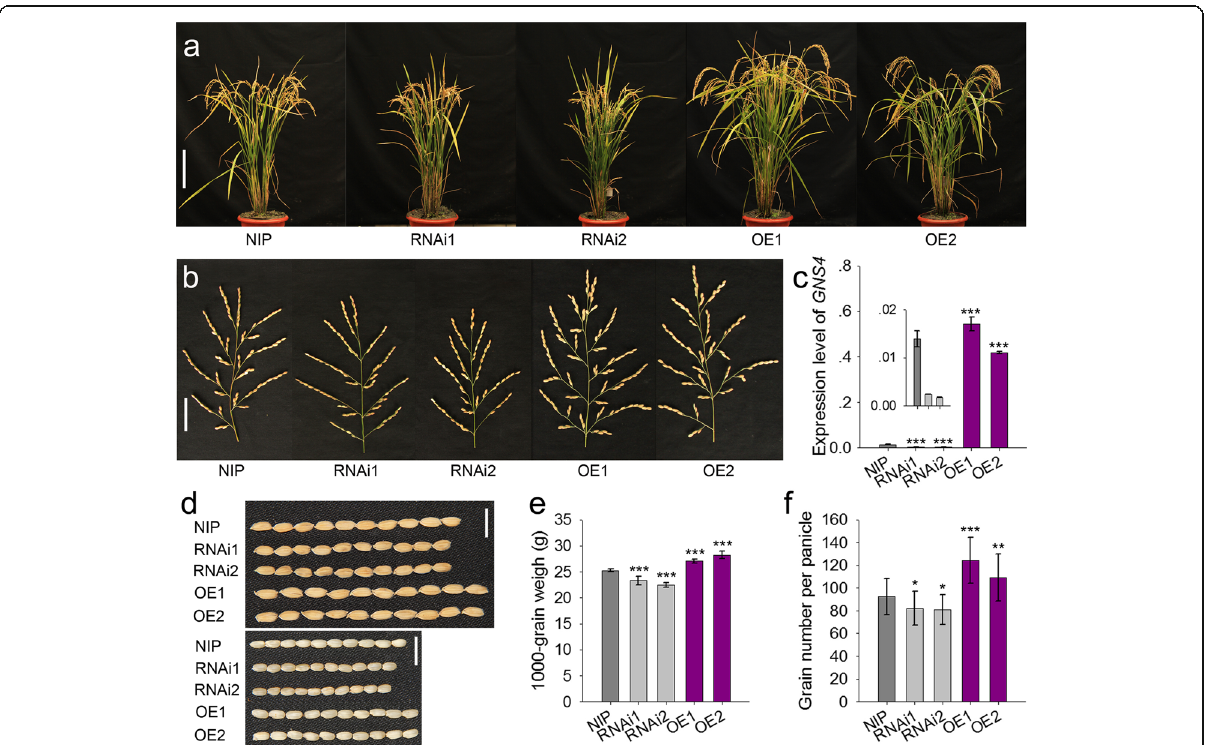
Fig. 3 RNAi and overexpression analysis of GNS4 gene in Nipponbare background. a Phenotypic features of GNS4 RNAi and overexpression transgenic plants. Bar, 20 cm. b Panicle architecture of GNS4 RNAi and overexpression transgenic plants. Bar, 5 cm. c GNS4 mRNA expression level of the RNAi and overexpression transgenic plants. The expression level of the rice Actin gene was amplified as a control. Values are means ± s.e. of four independent experiments. d Grains of the transgenic plants. Bar, 1 cm. e-f Comparison of 1000-grain weight and grain number per plant between Nipponbare and transgenic lines. Data are given as means ± s.e. ( n ≥ 13). Significant at ***0.1%, **1% and *5%. NIP, Nipponbare. RNAi1 and RNAi2 are two independent lines for RNAi analysis, and OE1 and OE2 are two independent lines for overexpression analysis